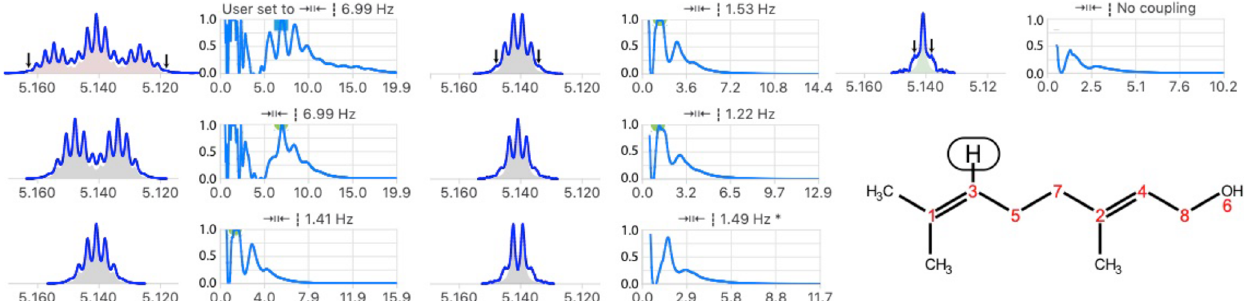
Figure 5. Example of automatic analysis failing to identify a triplet structure after six steps of simplification. Because the outermost lines (see arrows) were too small, it identified a problem because the reconstructed multiplet (triple quintet filled in red) was not perfectly matching (the scalar product was < 0.99) the starting multiplet (in blue). The post-analysis procedure found a satisfactory match (not shown) for a triplet (7.0Hz) caused by methylene (C5) of heptet ( 4 J = 1.3Hz) caused by the coupling with two methyl groups bound to C1 of geraniol.